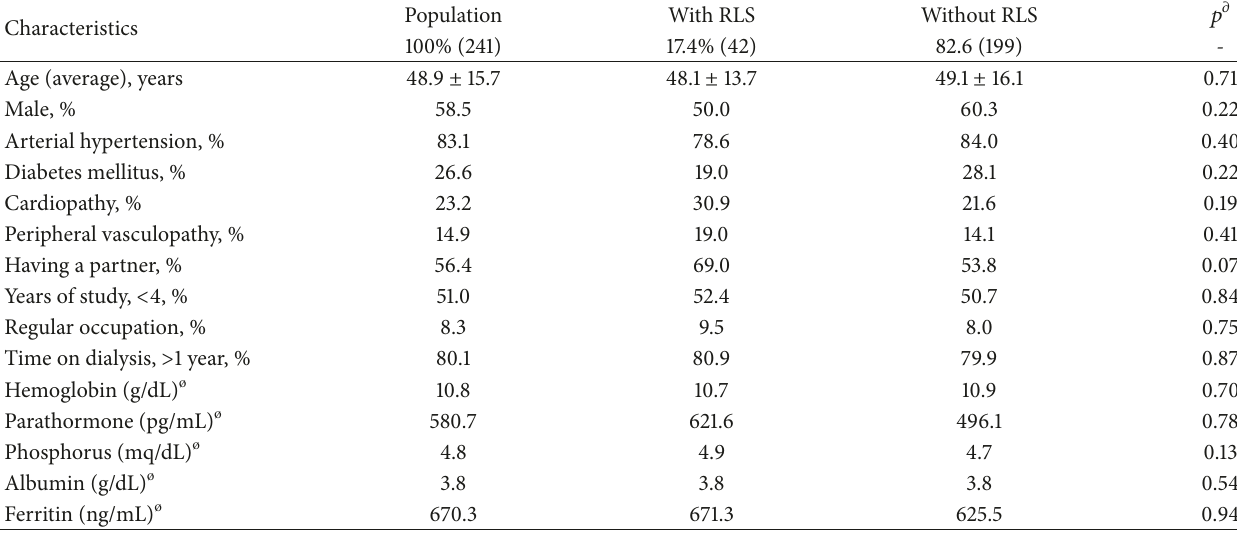
Table 1: Distribution of hemodialysis patients according to clinical-demographic characteristics, segregated according to the diagnosis of restless legs syndrome (RLS) ¢ ( 𝑁 = 241 ).